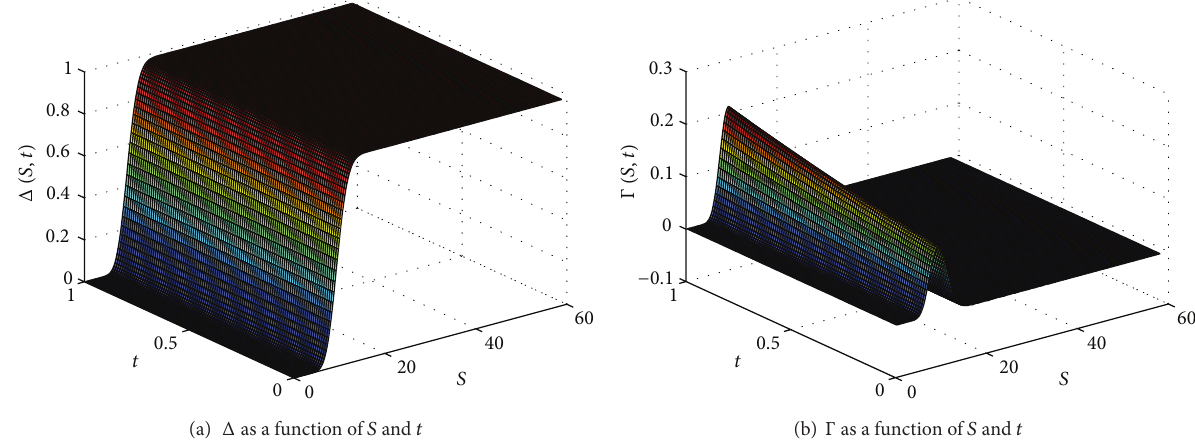
Figure 3: The Greek parameters for European call